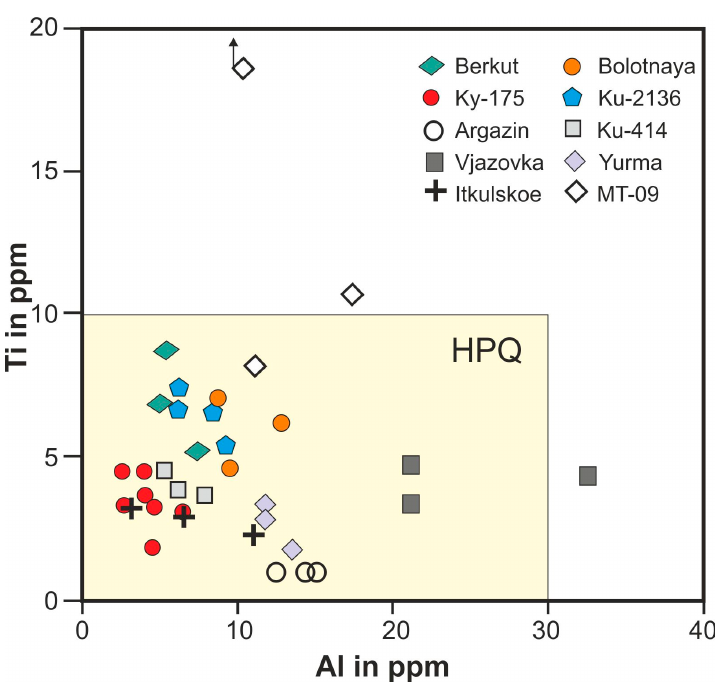
Figure 11. Ti and Al concentrations from laser ablation inductively-coupled plasma mass spectrometry (LA-ICP-MS) analyses of the quartz samples plotted into the field of high-purity quartz (HPQ) according to Harben [3] and Müller et al. [4].